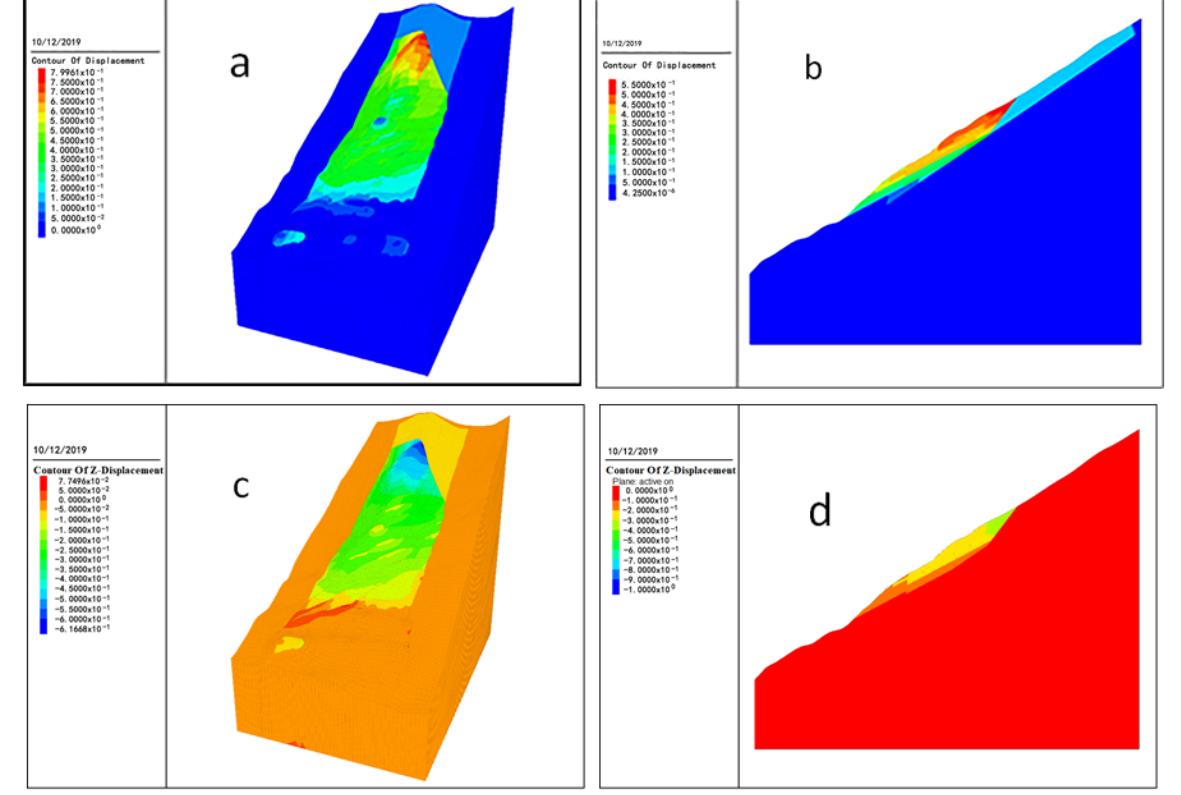
Figure 12. Displacement distribution in 10,000 steps of iteration. ( a ) Overall displacement distribution of YII4-3. ( b ) Displacement distribution at different elevations of YII4-3. ( c ) Overall displacement distribution of YII5-1. ( d ) Displacement distribution at different elevations of YII5-1.